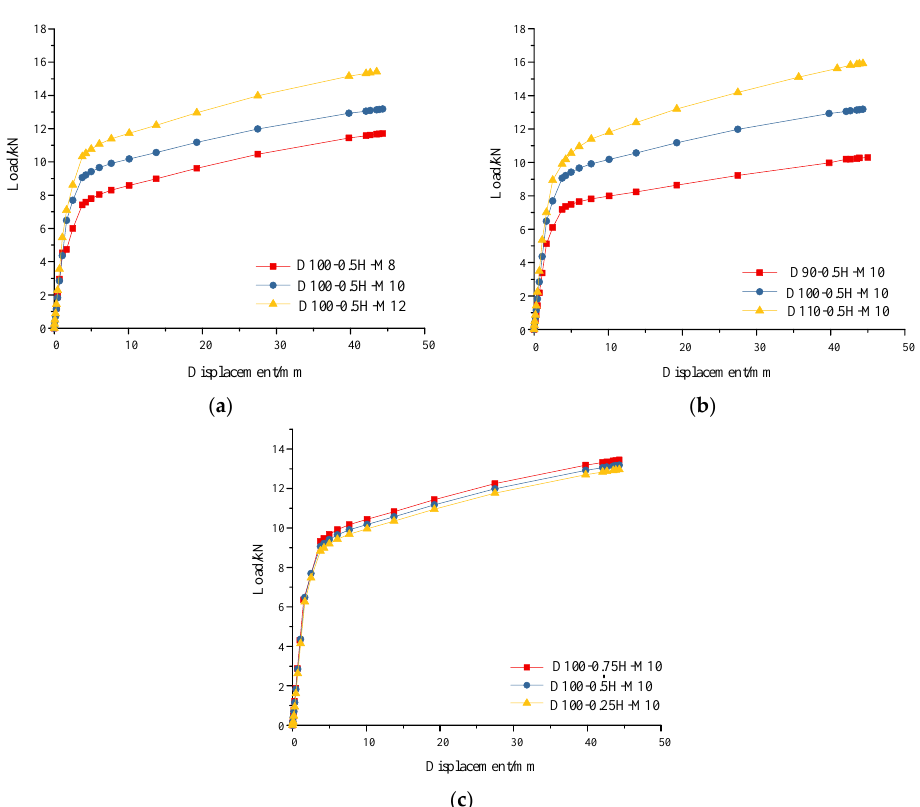
Figure 12. Effects of different structural parameters on bearing loads of the composite joints. ( a ) The effect of the bolt diameters on bearing load; ( b ) The effect of the bamboo outer diameters on bearing load; ( c ) The effect of the end space of the bolt on bearing load.